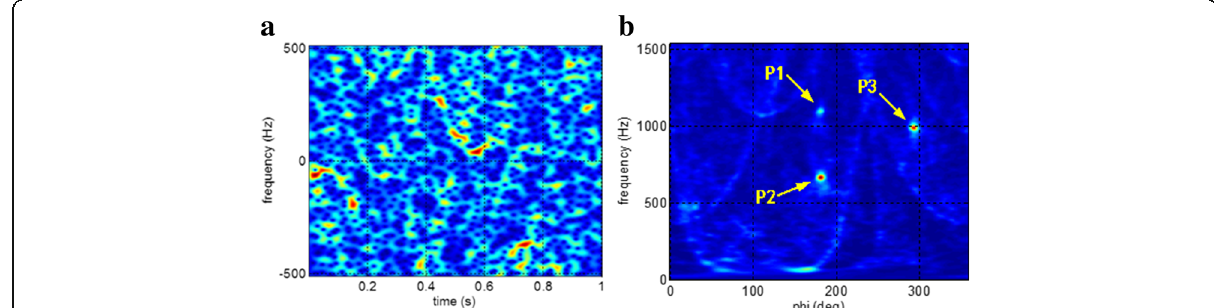
Fig. 8 Results of experiment No. 3. (carrier frequency: 220 GHz, SNR: − 3 dB, scattering centers: P1, P2, and P3). a The time-frequency image. b The parameter space